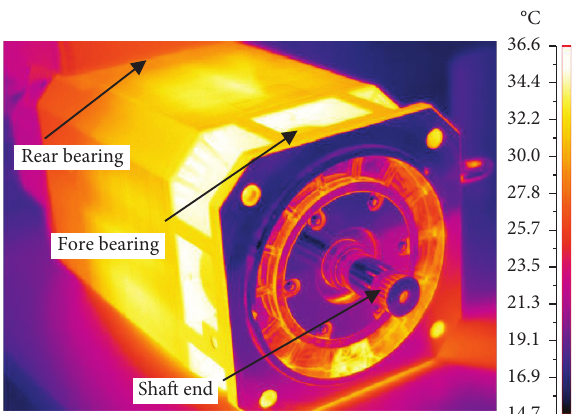
Figure 13: Schematic diagram of infrared thermal imager analysis/monitoring